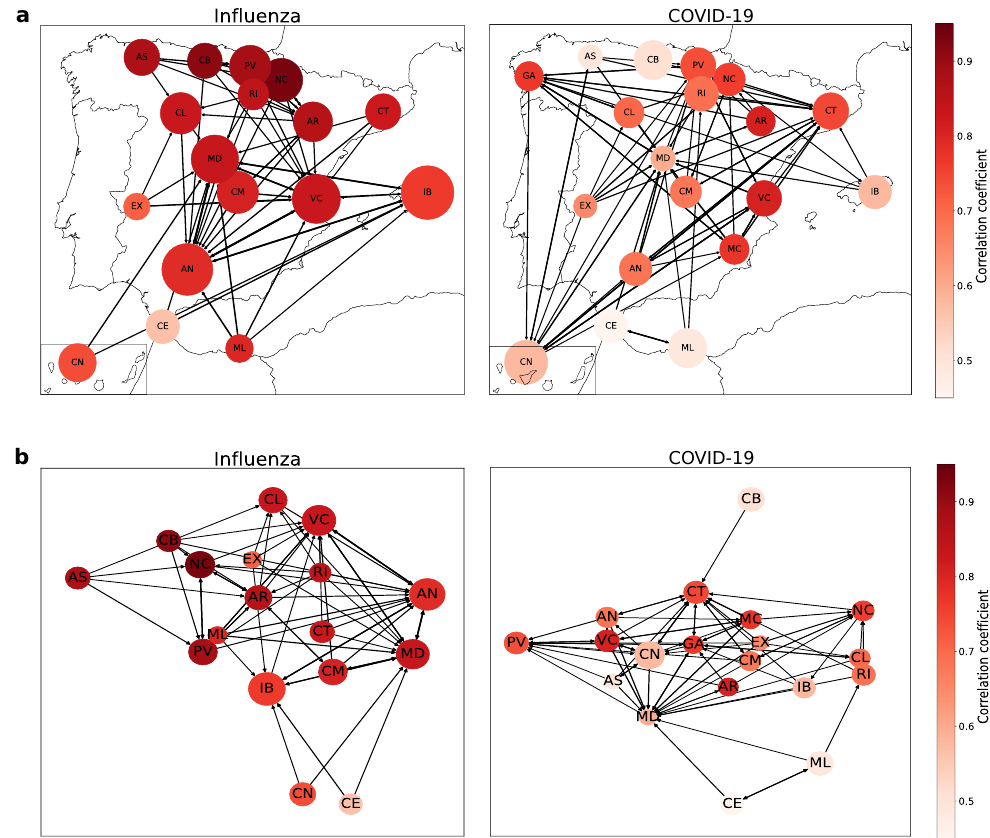
Figure 5. Influenza and COVID-19 networks. The size of the nodes is directly proportional to how many times a certain region has taken an example of itself. The darker a node is, the better it can be described—attending to the correlation coefficient ρ . Connection between generic regions A and B is plotted if the number of examples A takes from B overlaps 1.25 times the median number of examples A takes from other regions. ( a ) Geographical representation. ( b ) Graphical